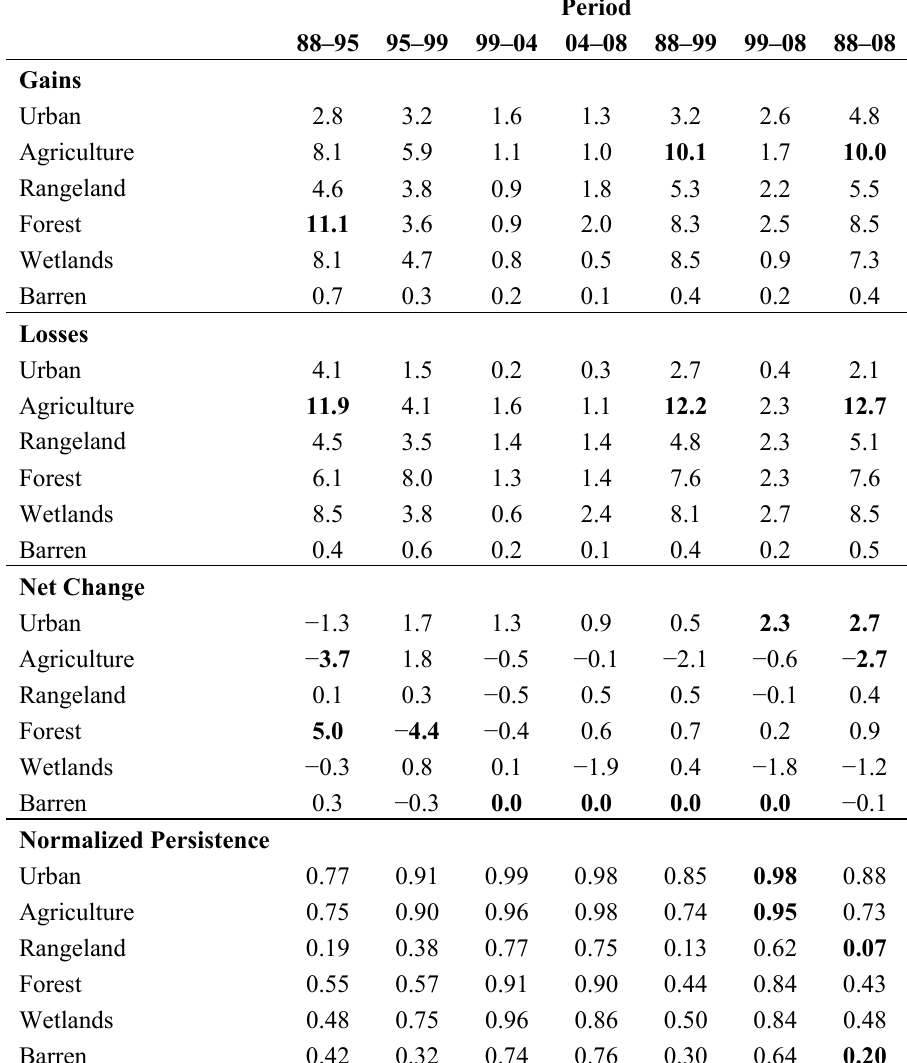
Table 3. Gains, losses, net changes and persistence of land uses in the Caloosahatchee River Watershed, based on existing